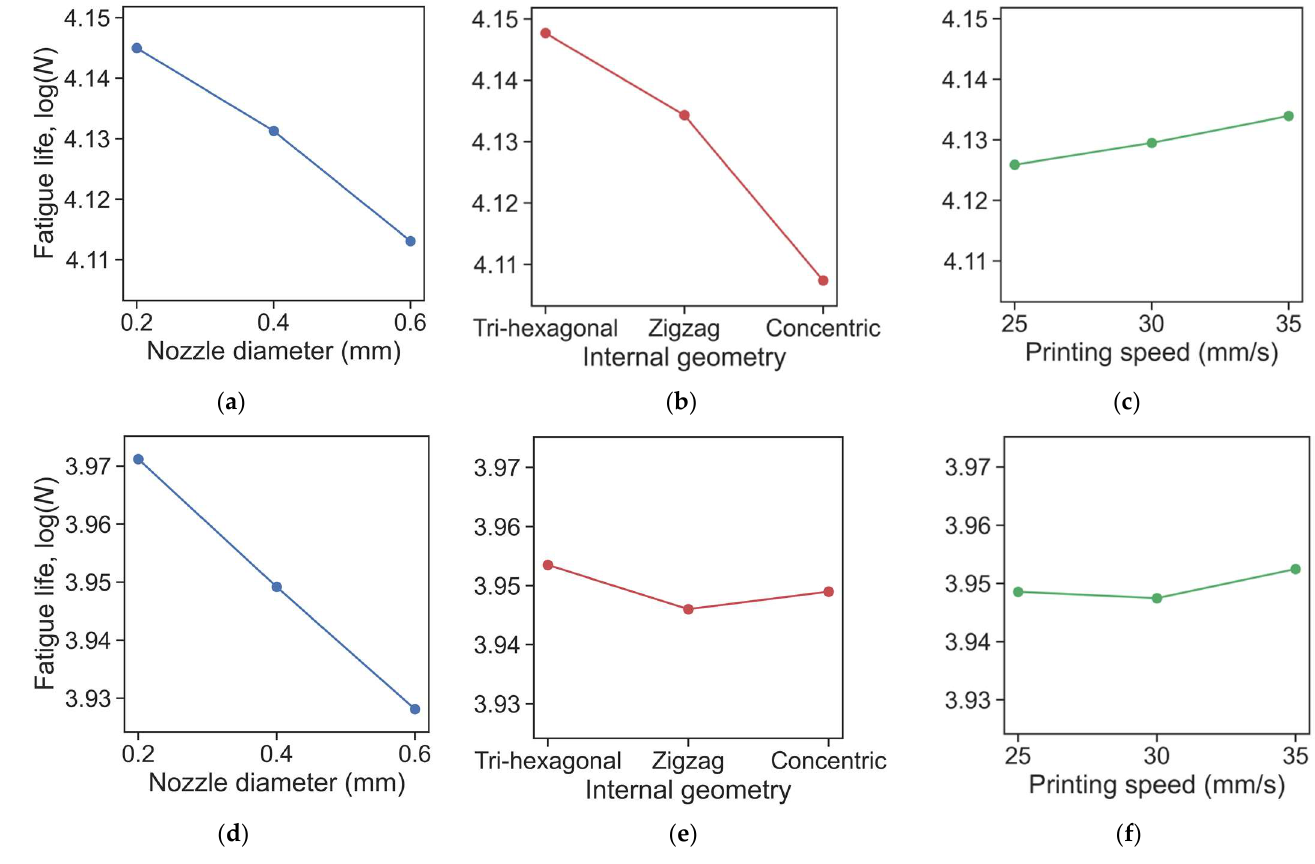
Figure 8. Sensitivity analysis of ABS ( a – c ) and Nylon ( d – f ) fatigue test for Nozzle diameter ( a , d ), Internal geometry ( b , e ), and Printing speed ( c , f ).